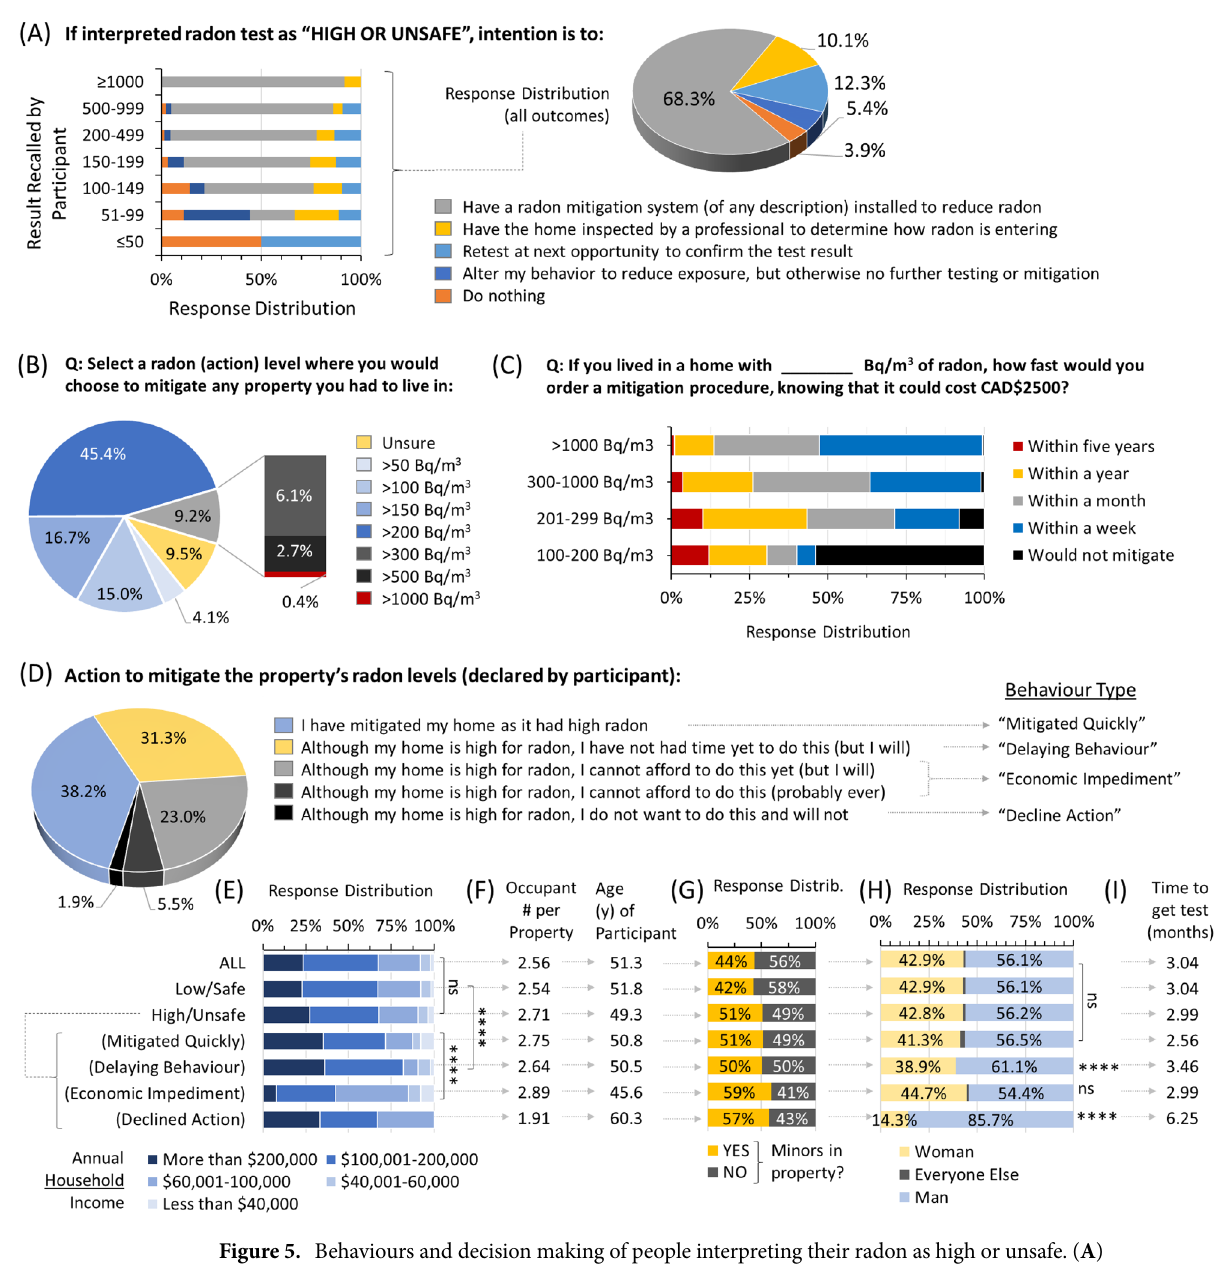
Figure 5. Behaviours and decision making of people interpreting their radon as high or unsafe. ( A ) Distribution of stated intentions after gaining direct knowledge of primary residence radon levels, for those who interpreted their outcome as ‘high or unsafe’, both overall (pie chart) and as a function of radon level (bar graph). ( B ) Distribution of responses to the radon level that a person would use as a threshold to guide a decision to obtain a professional radon mitigation. ( C ) Distribution of responses (as a function of radon level) to how fast an individual might order a radon reduction costing CAD$2,500 (a typical cost for a professional radon mitigation in Canada at the time of surveying). ( D ) Distribution of actions performed at the time of surveying, categorized into behaviour types. ( E ) Annual household income levels for all participants (ALL), those who either interpreted their radon level as ‘low/safe’ or ‘high/unsafe’, and also for those with ‘high/unsafe’ radon grouped by behaviour types outlined in ( D ). ( F ) Geometric mean occupants per property and age of primary respondent for groups defined in ( E ). ( G ) Sex/gender distribution for groups defined in ( E ). ( H ) Geometric mean time to obtain a radon test for groups defined in ( E ). ( I ) Response distribution to whether there were children living in property at time of radon testing, for groups define in ( E ). Statistical comparisons are 1-way ANOVA. ****p < 0.0001; ns = p > 0.05. Figures were prepared using Excel and GraphPad Prism 9.1.1 (225) (www. graph pad.